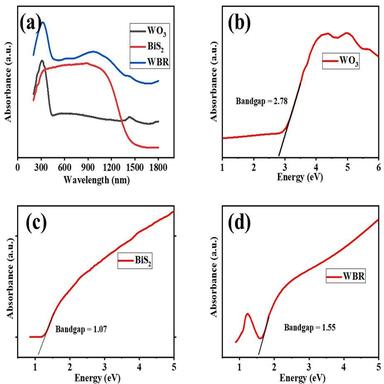
Absorption spectra of individual WO3, BiS2 and their composite WBR (a). Optical bandgap spectra for WO3, BiS2 and WBR (b, c and d).